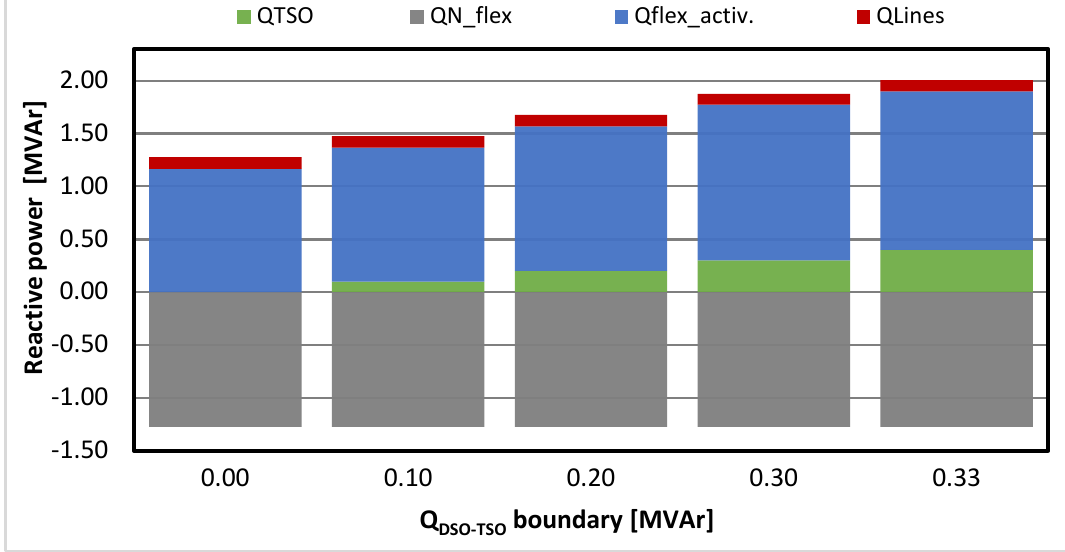
Table 4. Reactive power balance for increasing TSO capacitive needs at each market session